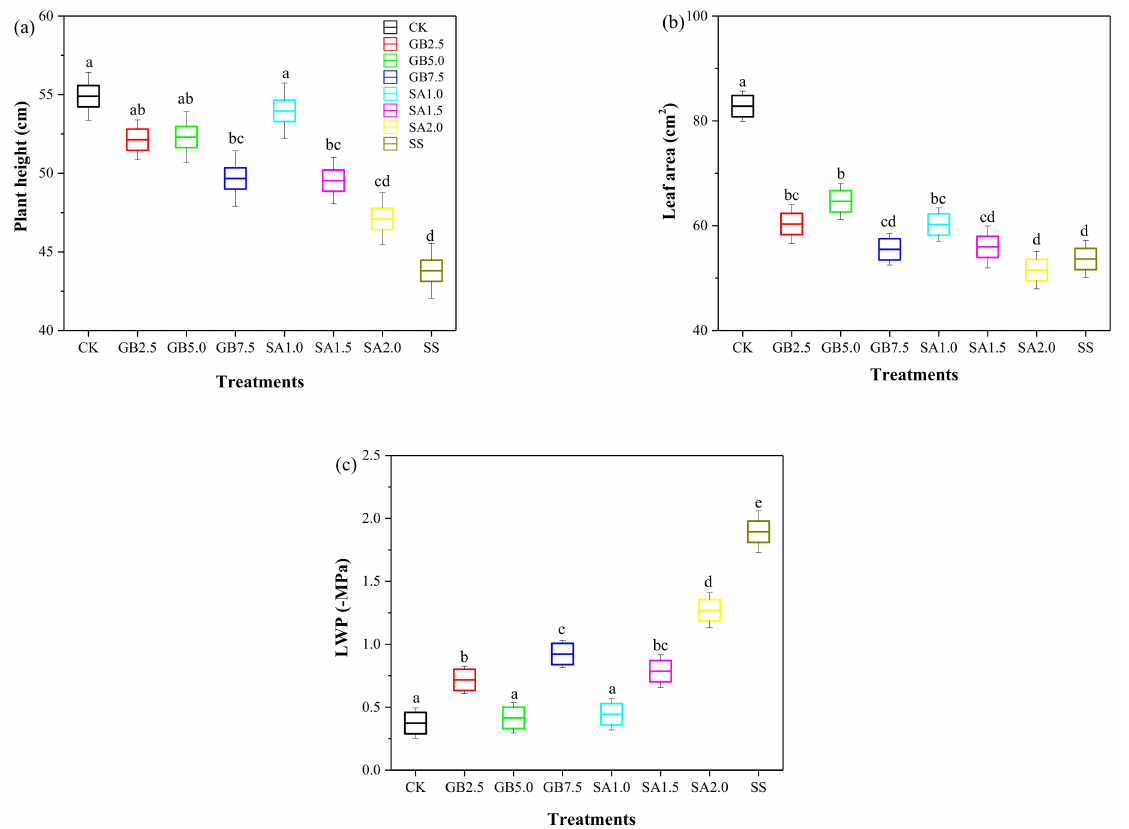
Figure 1. Effect of exogenous glycine betaine (GB) and salicylic acid (SA) on ( a ) plant height, ( b ) leaf area, and ( c ) leaf water potential (LWP) of 150 mM NaCl-stressed seedlings. Treatments: CK, control; GB2.5, 2.5 mM GB; GB5.0, 5.0 mM GB; GB7.5, 7.5 mM GB; SA1.0, 1.0 mM SA; SA1.5, 1.5 mM SA; SA2.0, 2.0 mM SA; SS, salt stress (150 mM) without supplementation. Values are means ± standard deviation (n = 3). Different letters represent significant differences at p < 0.05 between the experimental